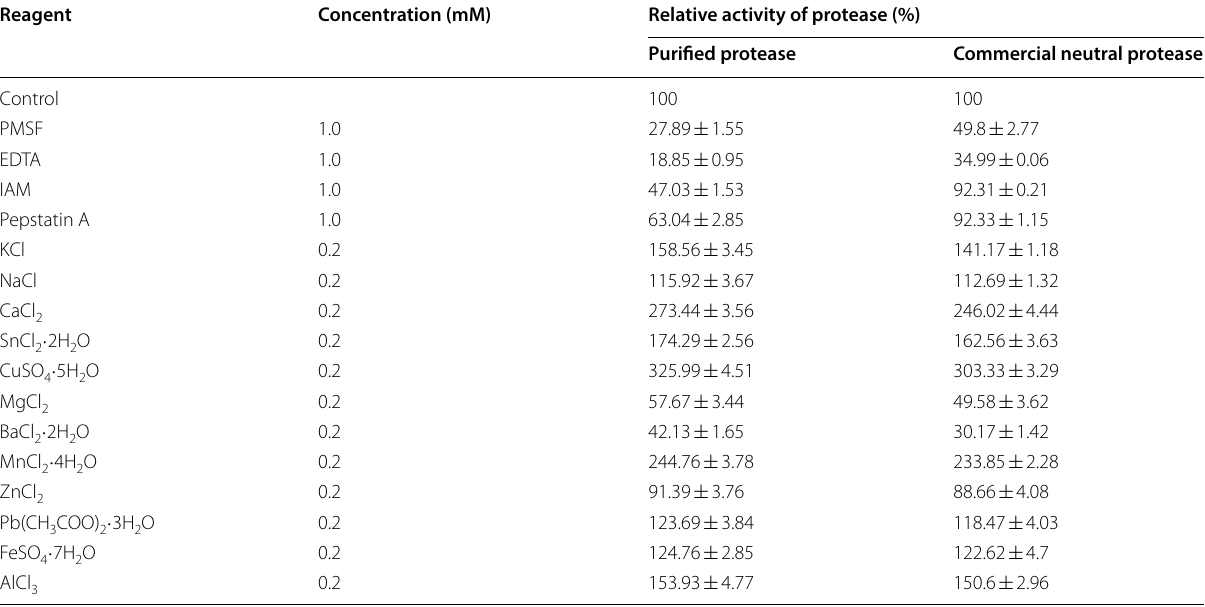
The purified protease activity from Aspergillus oryzae Y1 and commercial neutral protease activity without the addition of metal ions was defined as